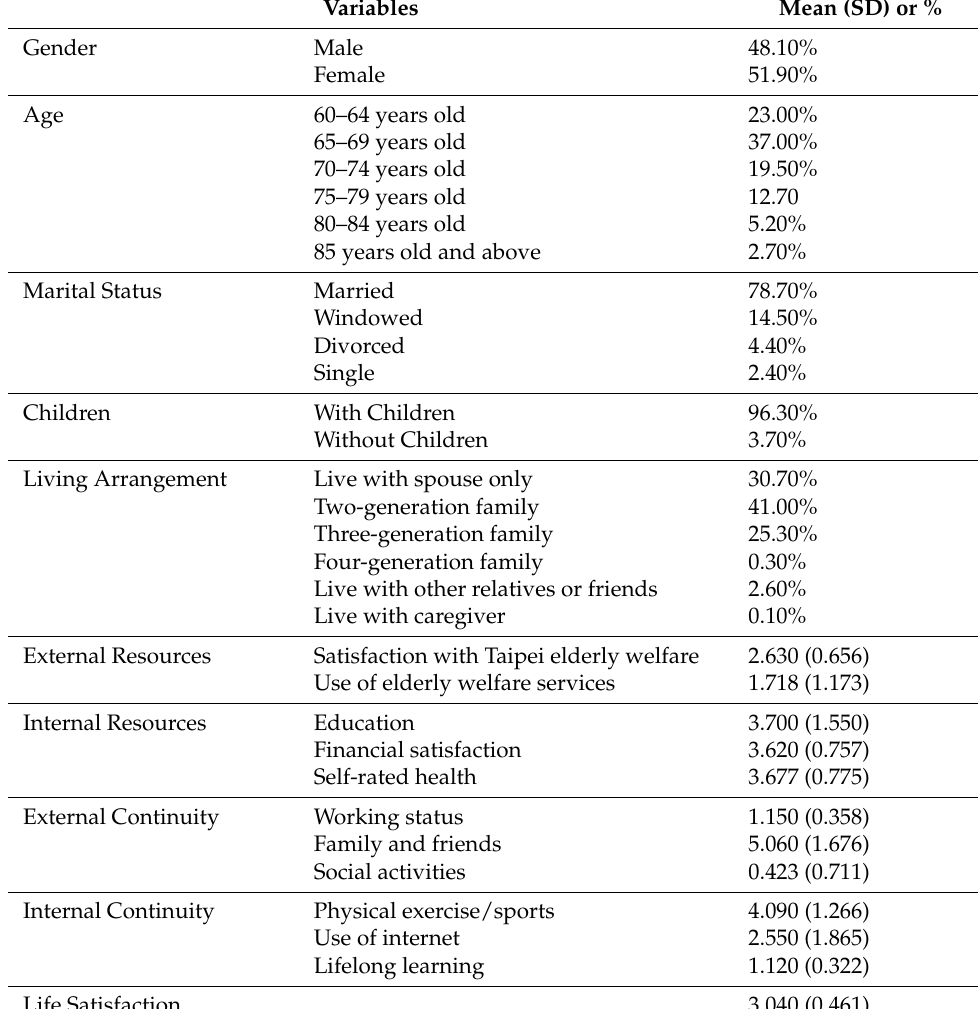
Table 2. Characteristics of the sample.